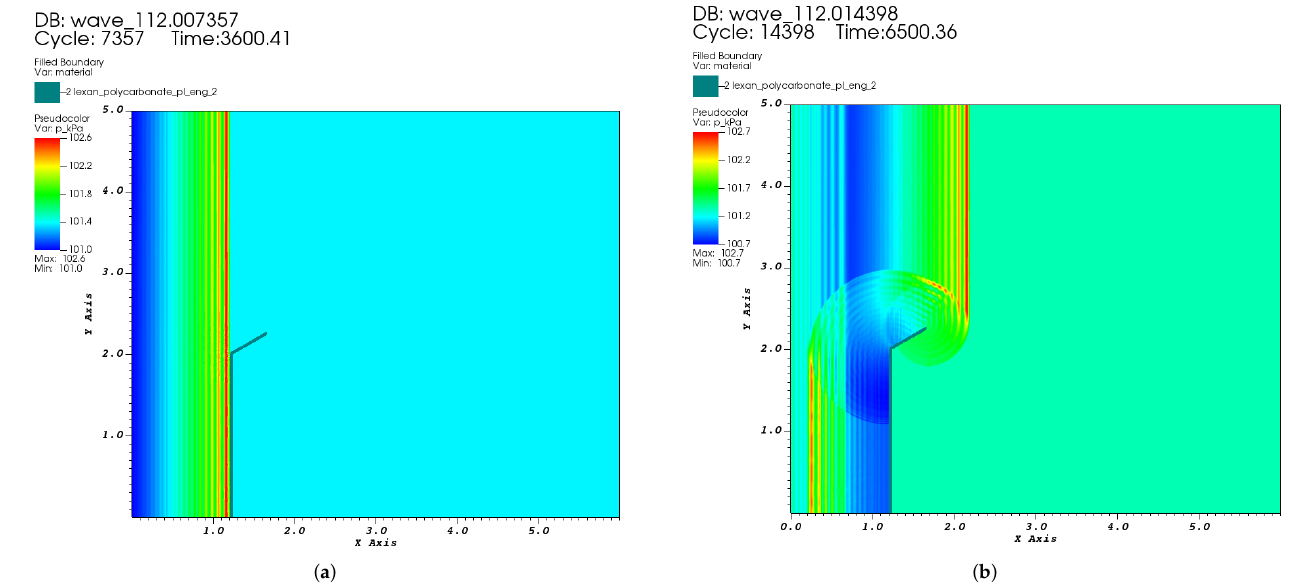
Figure 8. Images from a representative 2D plane strain blast-barrier mitigation simulation: ( a ) at arrival time of wave at barrier. ( b ) During dynamic interaction event.